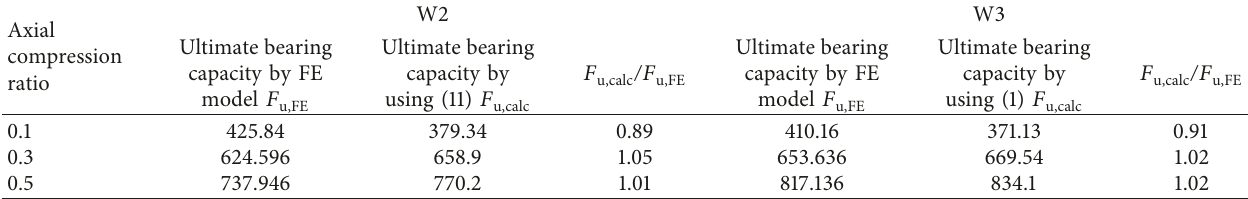
Figure 32: The stress-strain distribution of the section considering the different intensity grades. Table 8: Comparison of the ultimate bearing capacity between calculations and